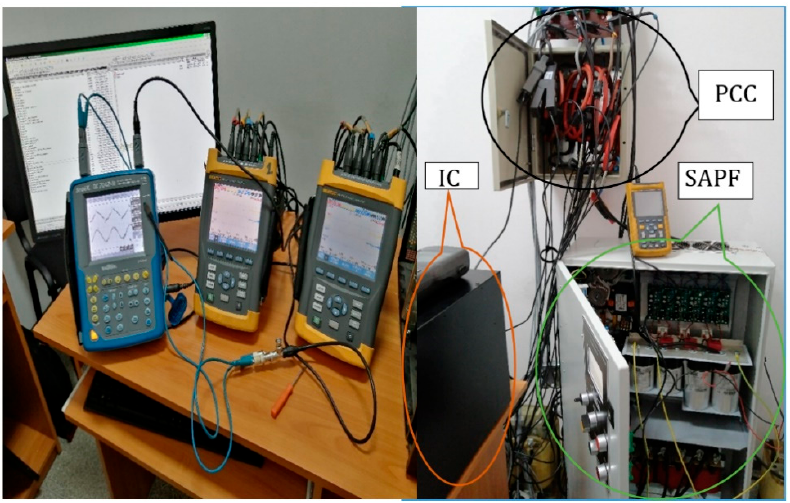
Figure 7. Picture of the experimental setup. 4. Four-Wire Three-Leg SAPF and the Control System The four-wire SAPF with split compensation capacitor has a known structure and is made with IGBT transistors (Figures 8 and